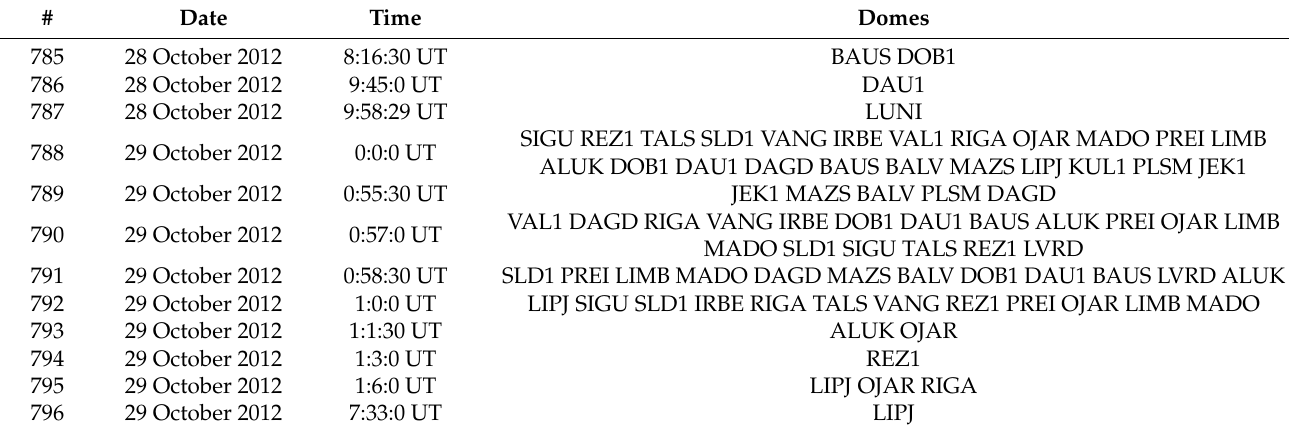
Figure 5. Plot of the distribution of simultaneously occurred discrepancies in December 2009. Table 3 (and Supplementary Materials Tables S4, S7) lists the DOMES names of the stations, where the faulty solutions occurred simultaneously, the date and time are fixed. Similar information is obtained for all the selected months in a period of 11 years.